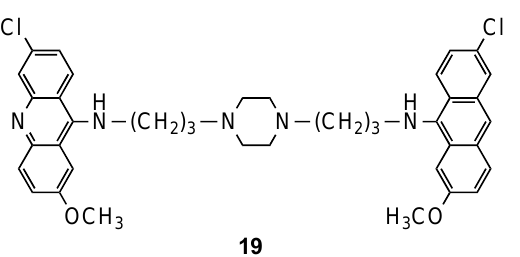
Figure 13. Compound 19 developed by Caffrey and co-workers [28].